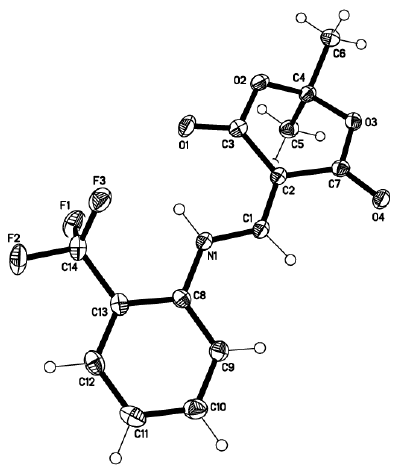
Figure 1. Molecular structure of 3 with anisotropic displacement ellipsoids drawn at the 50% probability level.